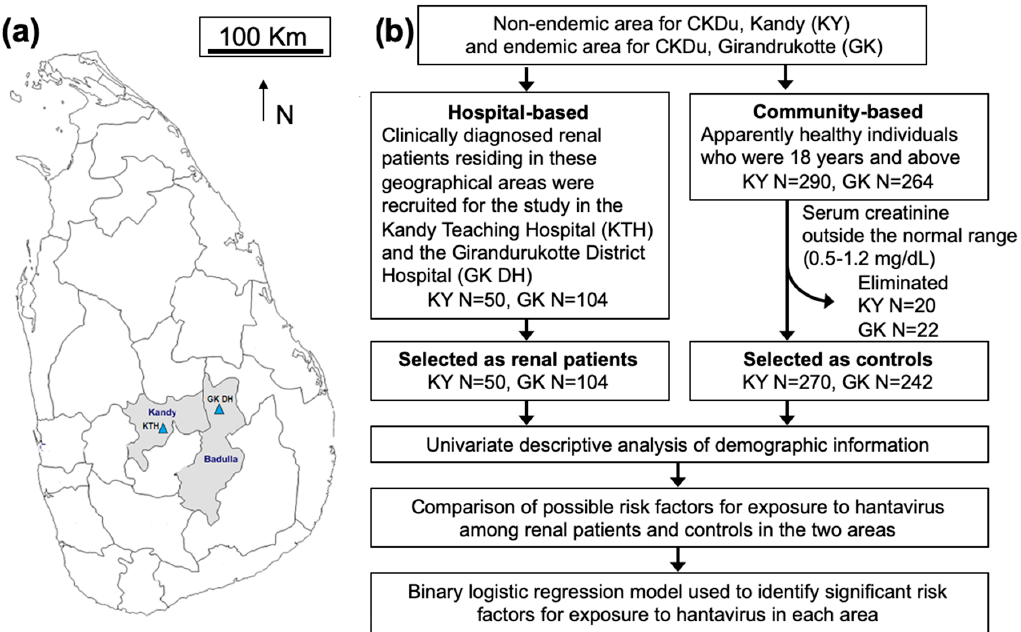
Figure 1. Study area and design. ( a ) Kandy and Badulla districts of Sri Lanka and the sampling locations. The map shows the locations of Kandy Teaching Hospital (KTH) and Girandurukotte District Hospital (GK DH). ( b ) Flow chart summarizing the selection process for renal patients and controls and the statistical analyses. Blood and demographic information were collected from individuals.